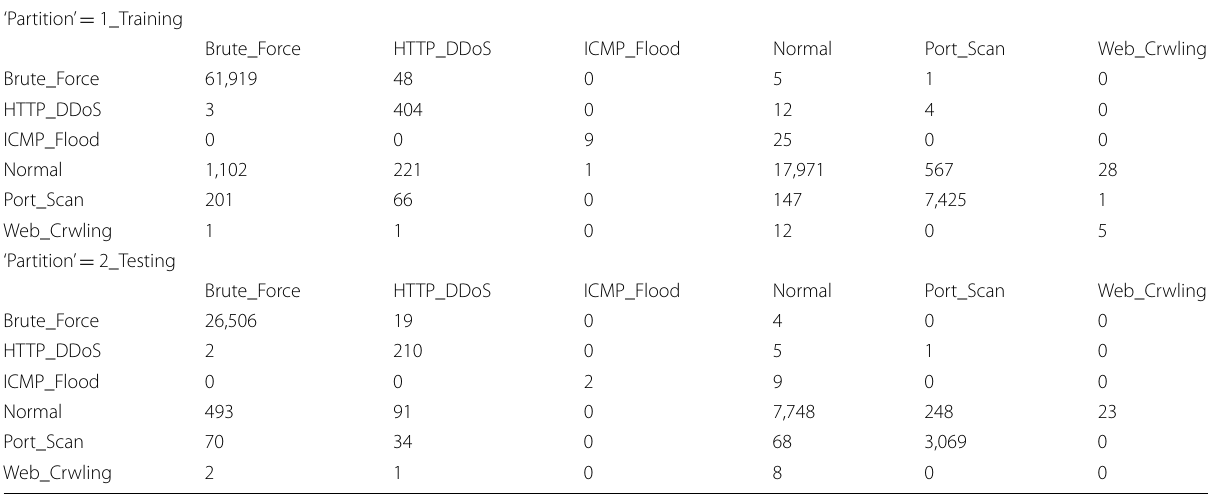
Table 4 Confidence matrix for Bayesian